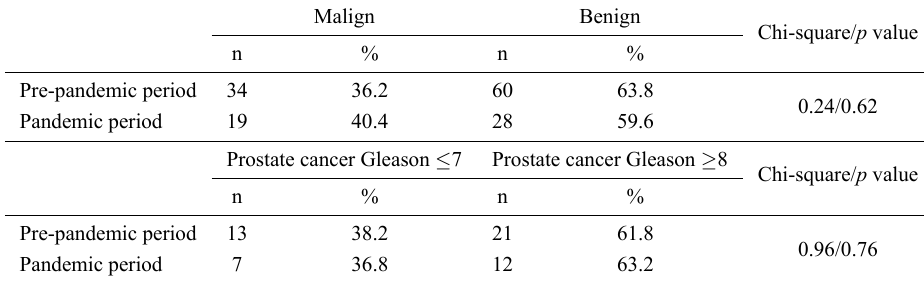
Table 2. Prostate biopsy results in the pre-pandemic and the pandemic